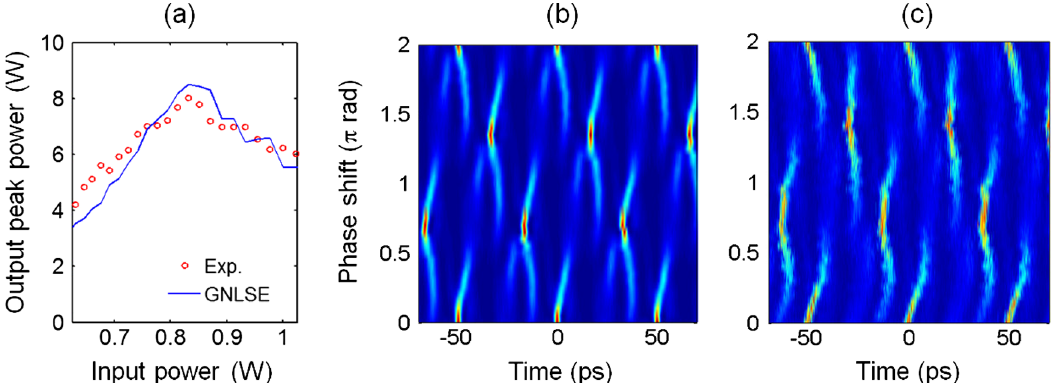
FIG. 8. (a) Highest peak power of the temporal profile recorded at the fiber output as a function of the average input power of the bimodulated wave. (b-c) Evolution of the temporal wave profile as a function of the initial phase difference (cid:1) ’ between both ABs. (b) Results from GNLSE simulations and (c)